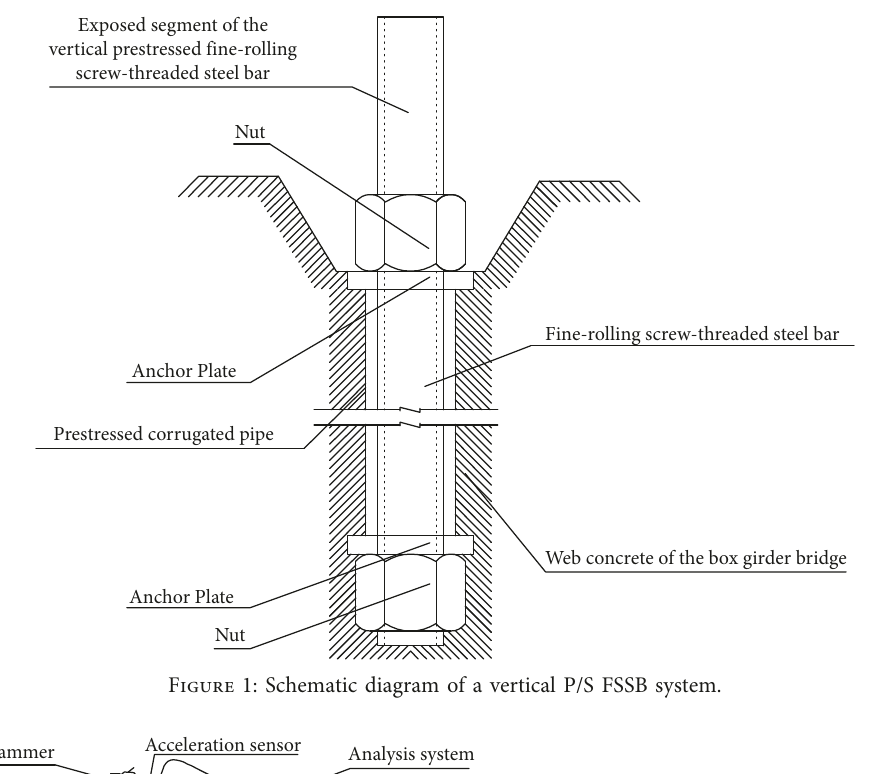
Figure 1: Schematic diagram of a vertical P/S FSSB system.